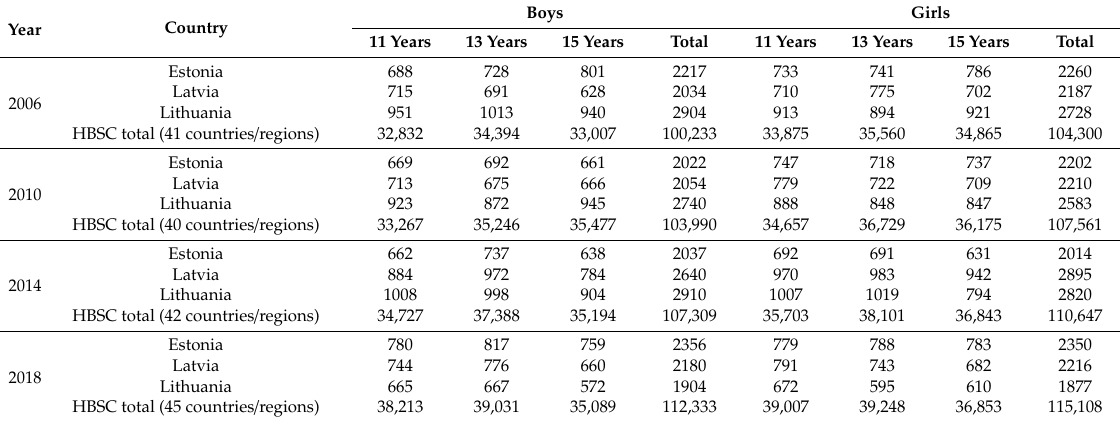
Table 1. Number of respondents by country, survey year, gender and age